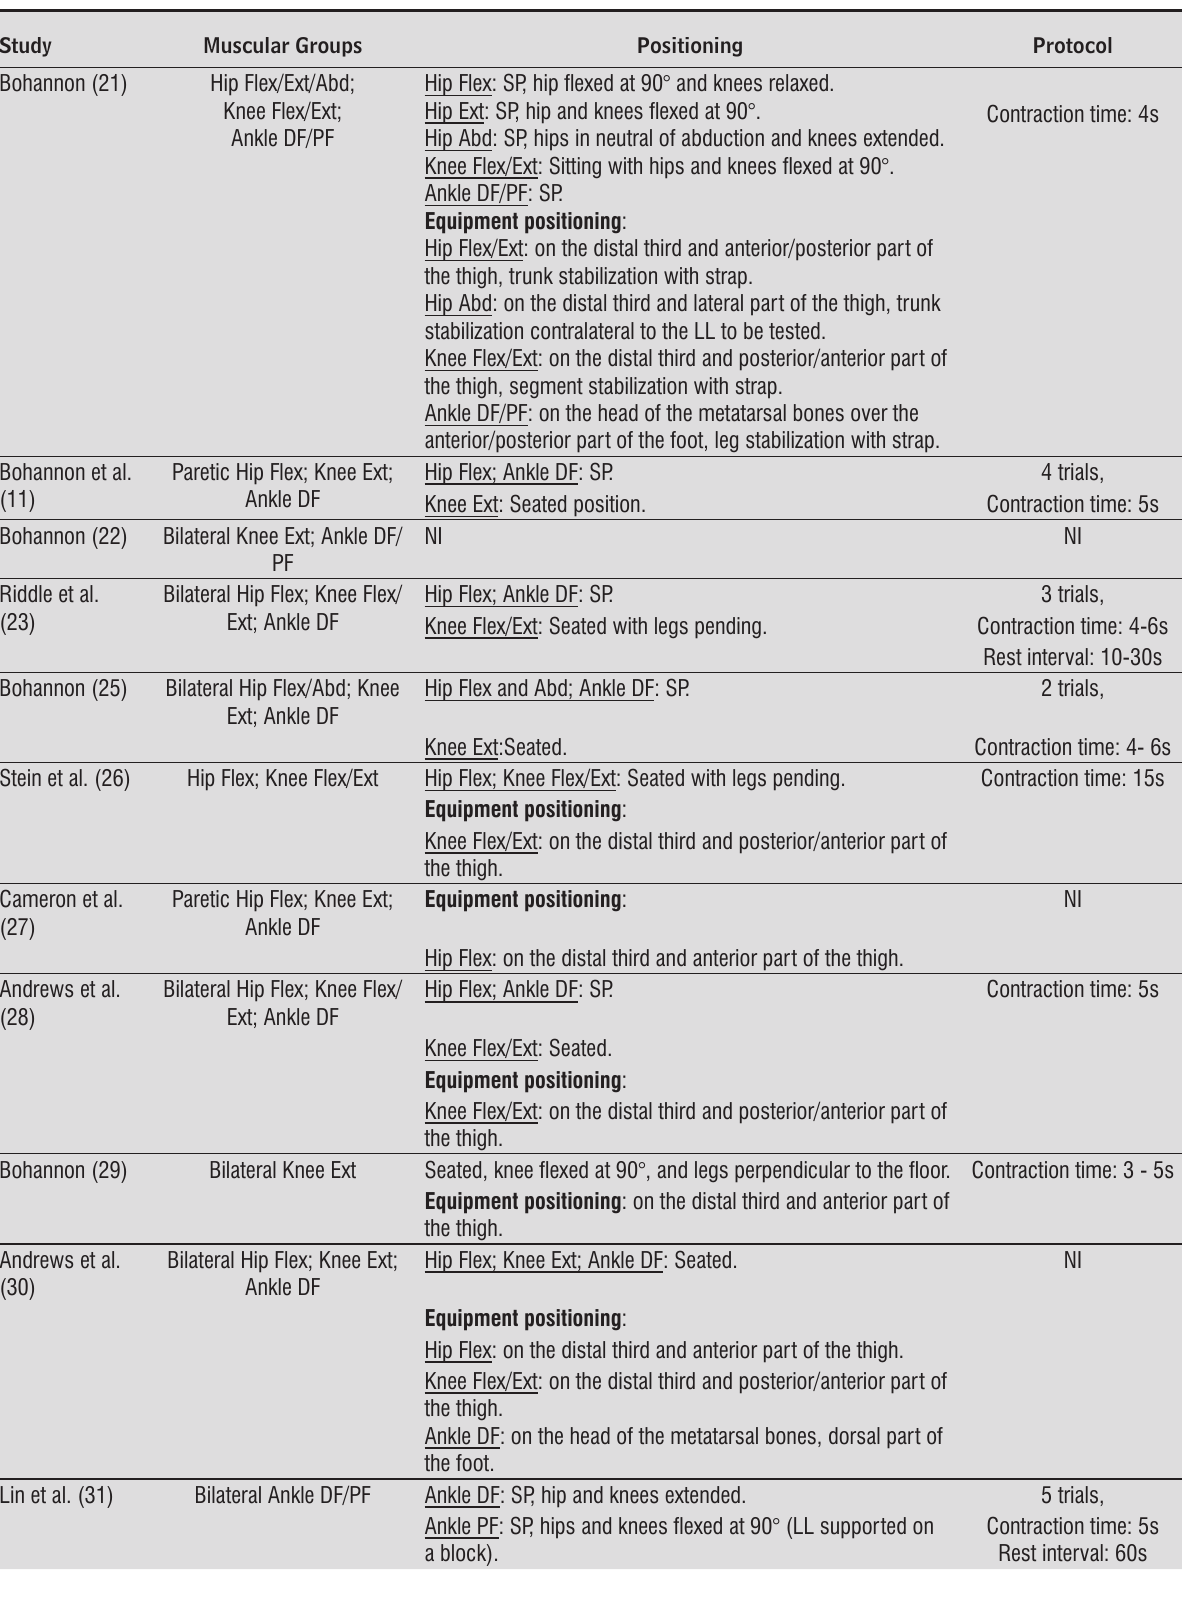
Table 2 - Data extraction of the 30 studies, which assessed the strength of the lower limb muscles with portable dynamometry in subjects with stroke and provided information regarding the positioning or the data